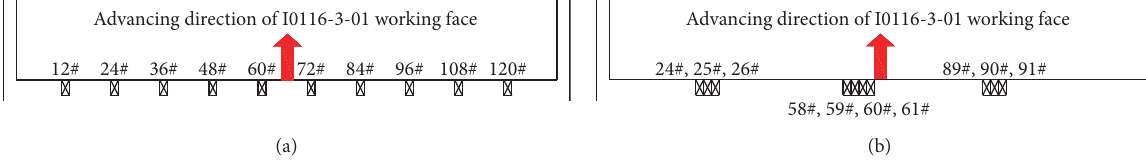
Figure 7: Installation location of transducers. (a) Before water inrush disaster. (b) After water inrush